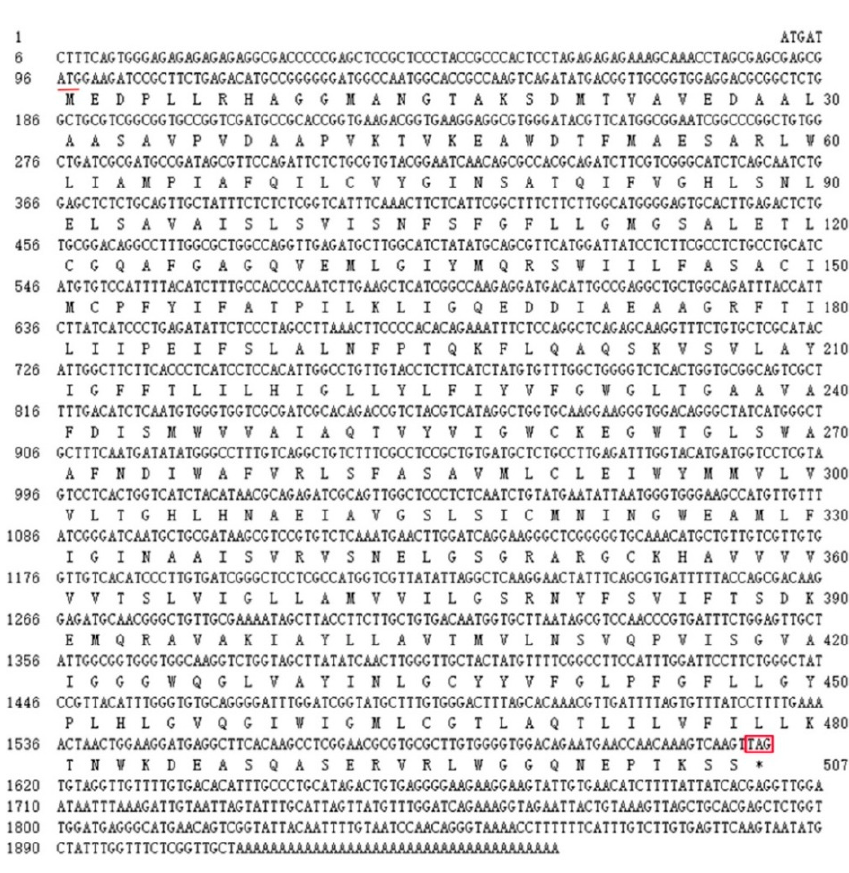
Figure 2. Nucleotide and deduced amino acid sequences of the LhDTX35 gene. The initiation codon is underlined, while the stop codon is labeled with an asterisk and box.